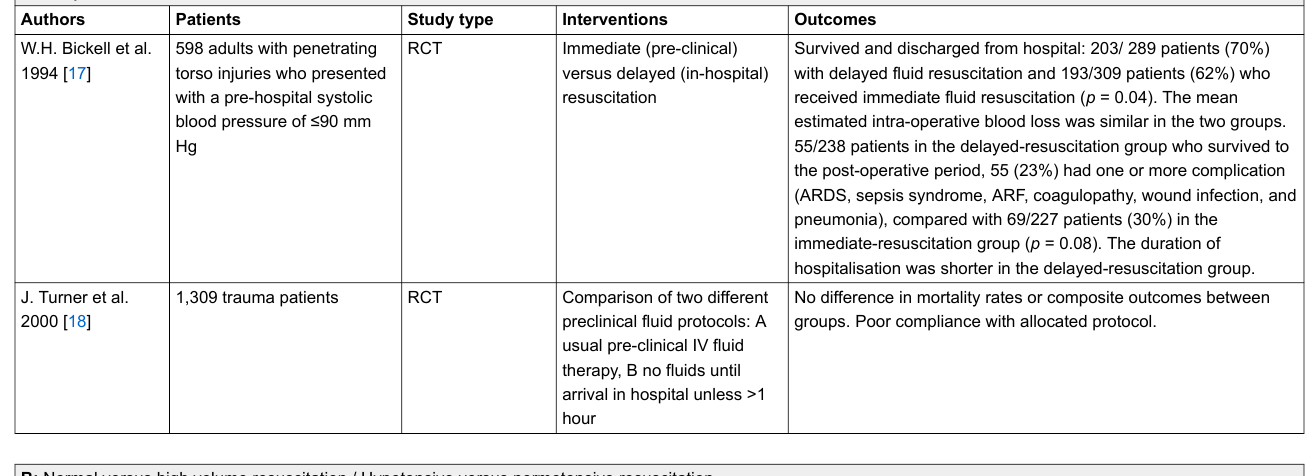
Table 1: Clinical studies. A: Early versus late fluid resuscitation.